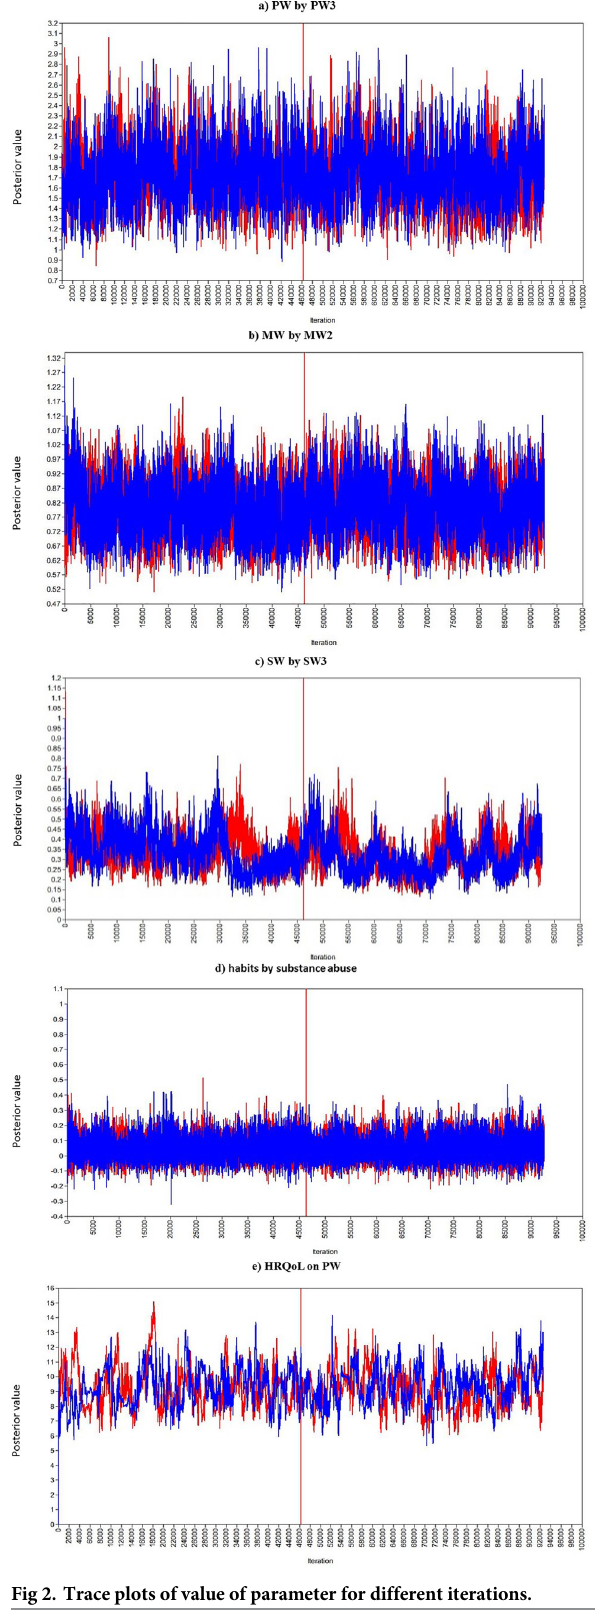
Fig 2. Trace plots of value of parameter for different iterations. https://doi.org/10.1371/journal.pone.0252205.g002 PLOS ONE | https://doi.org/10.1371/journal.pone.0252205 May 28,